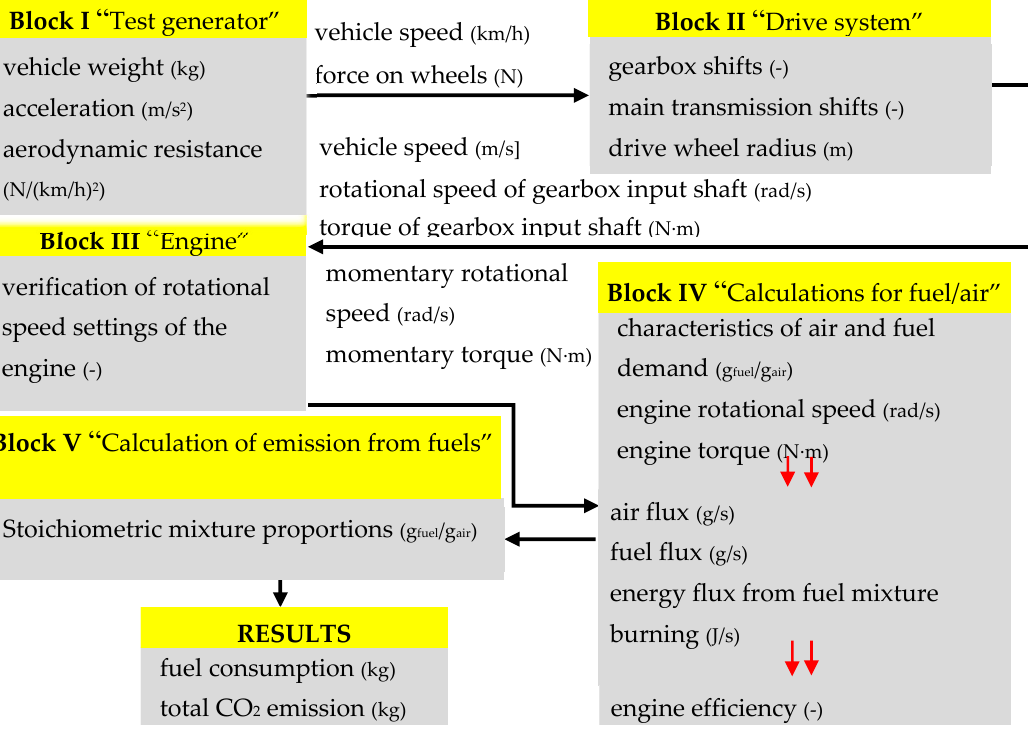
Figure 1. Diagram of the 1.3 MultiJet engine simulation model.